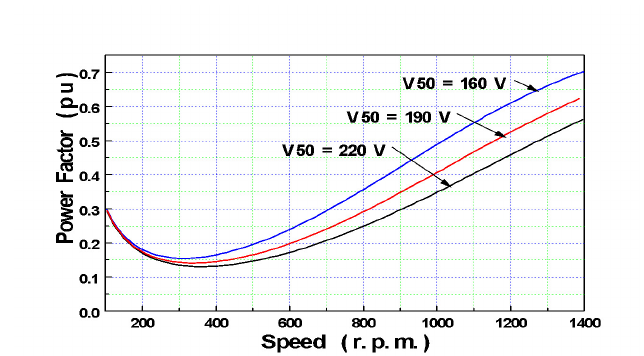
Fig. 9. Variation of motor power factor with speed (Computed).